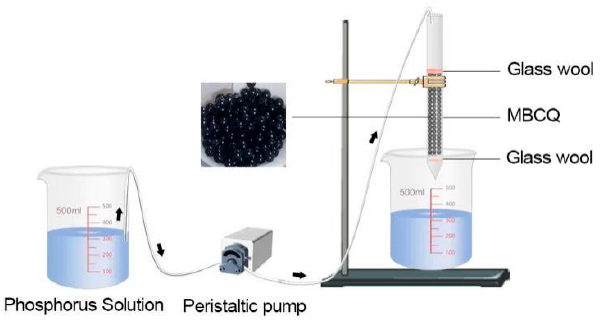
Figure 2. Schematic of the fabrication process of MBCQ.